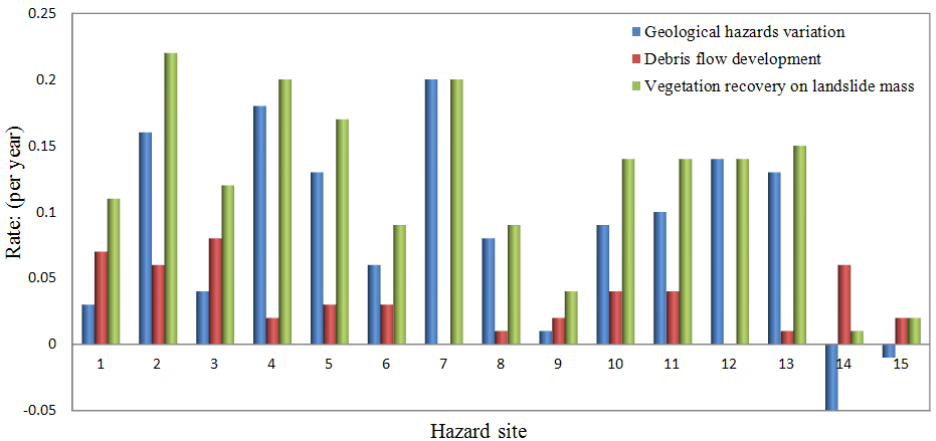
Figure 7. Comparison of hazard development rates from 2008 to